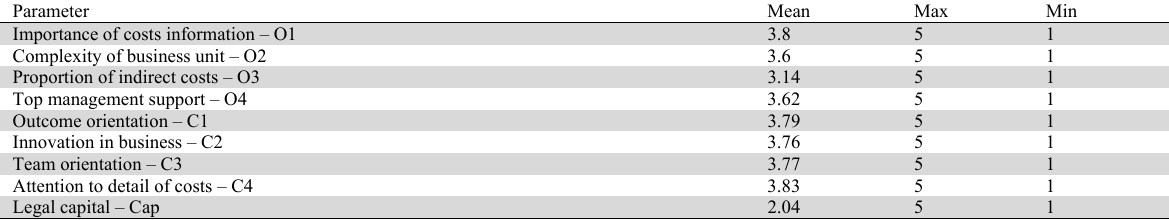
Descriptive statistics of parameters of organizational and cultural factors.